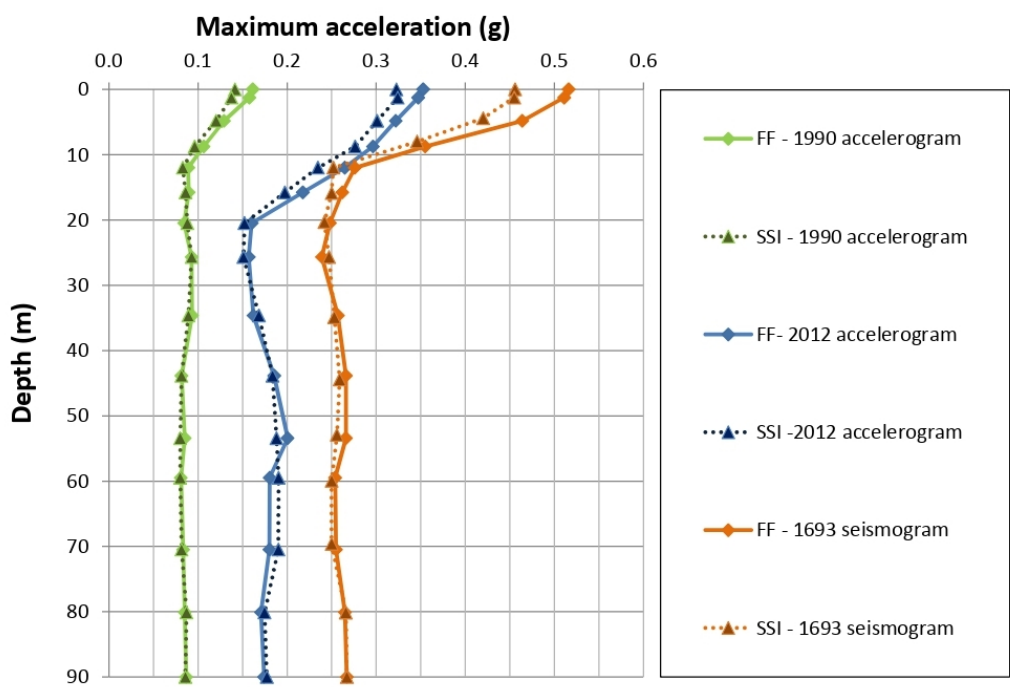
Figure 25. Maximum accelerations along SSI and FF alignments: using the 1990, 2012, and 1693 seismic inputs. The values of the surface maximum accelerations and soil amplification factors R for the SSI and FF alignments are reported in Table 7. Table 7. Values of the surface maximum accelerations and soil amplification factors. FF: SSI: FF, 1990 SSI, 1990 FF, 2012 SSI, 2012